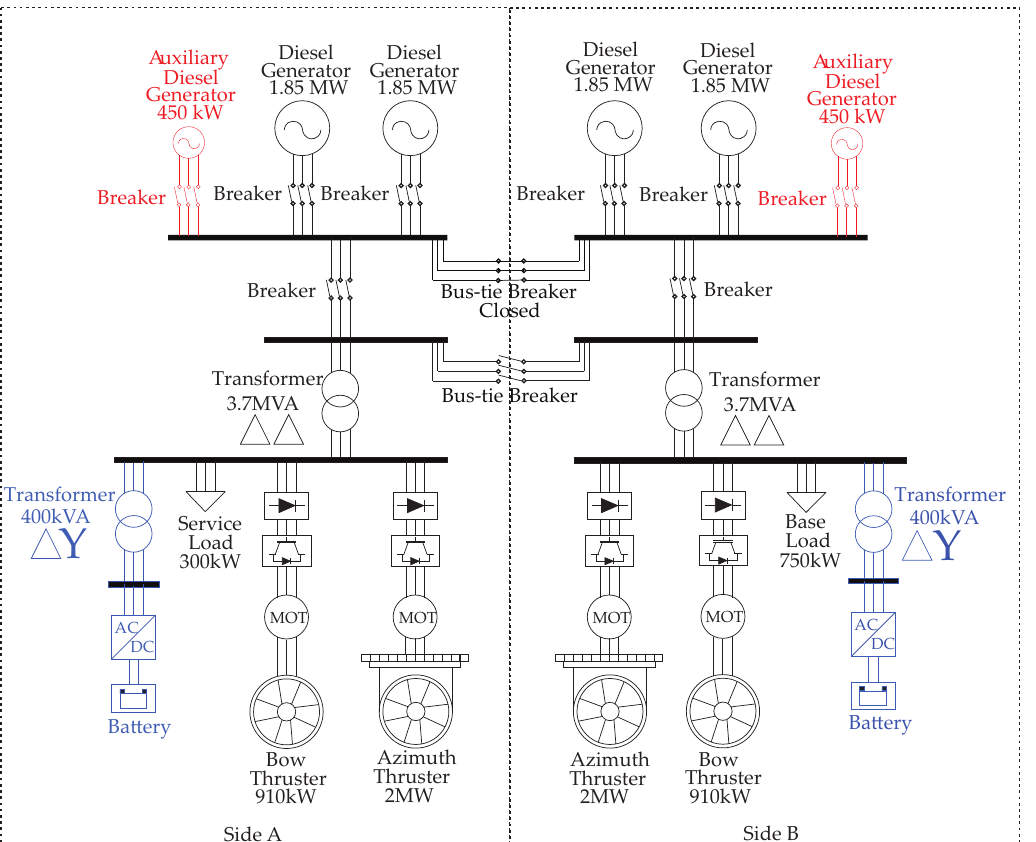
Figure 3. Power system diagram of the Platform Supply Vessel (PSV) considered. The base case analyzed is in black. The components connected to the base case to evaluate the potential of auxiliary generators are in red. The ones related to batteries are in blue. The last analysis pursued (auxiliary generators + batteries) comprises all the elements of this